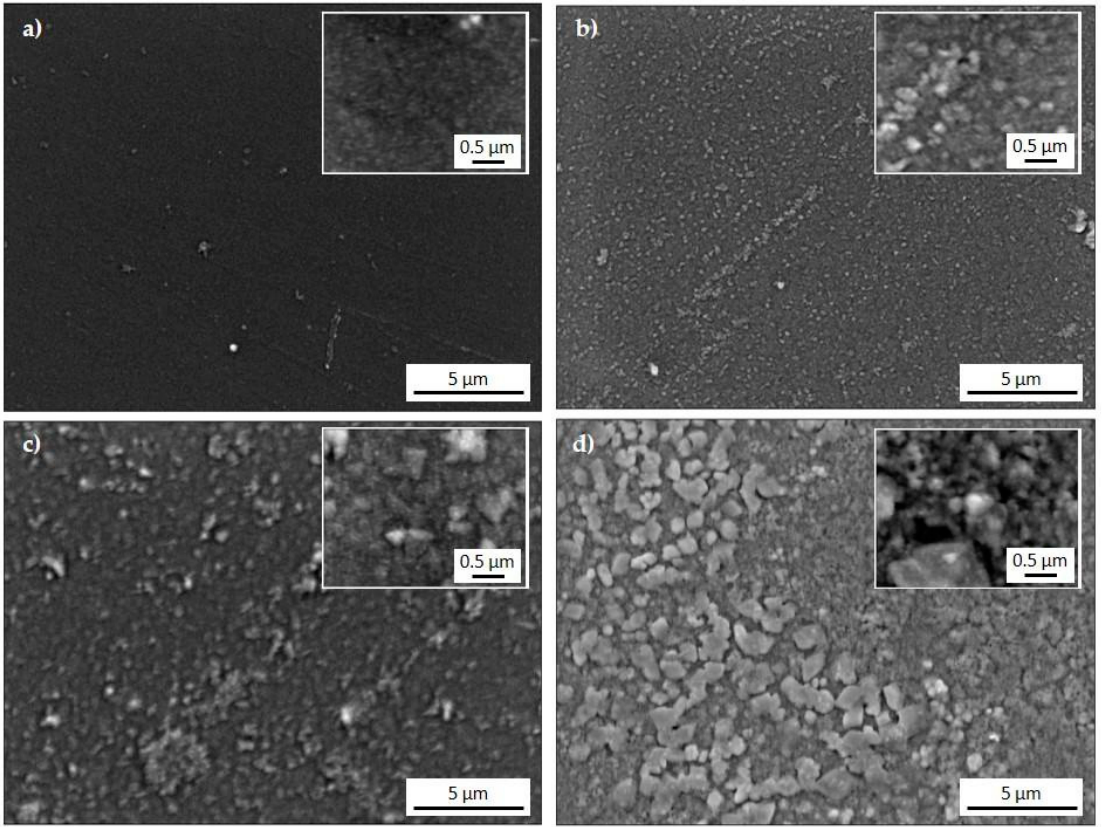
Figure 3. SEM images of the “as-prepared” samples: ( a ) quartz glass; ( b ) ITO; ( c ) soda-lime glass; ( d ) (111) gold. Insets display zoomed views of the same images.